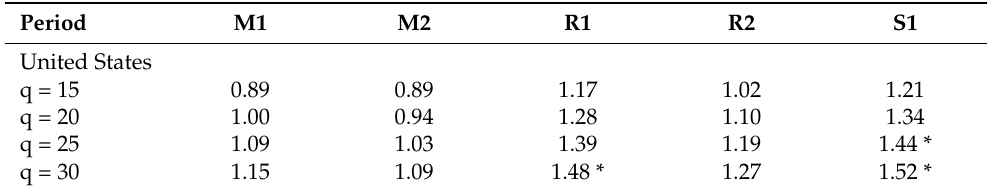
Table 2. Variance-ratio test results of daily spot gold price return series: January 1981 to Decem- ber 2015.